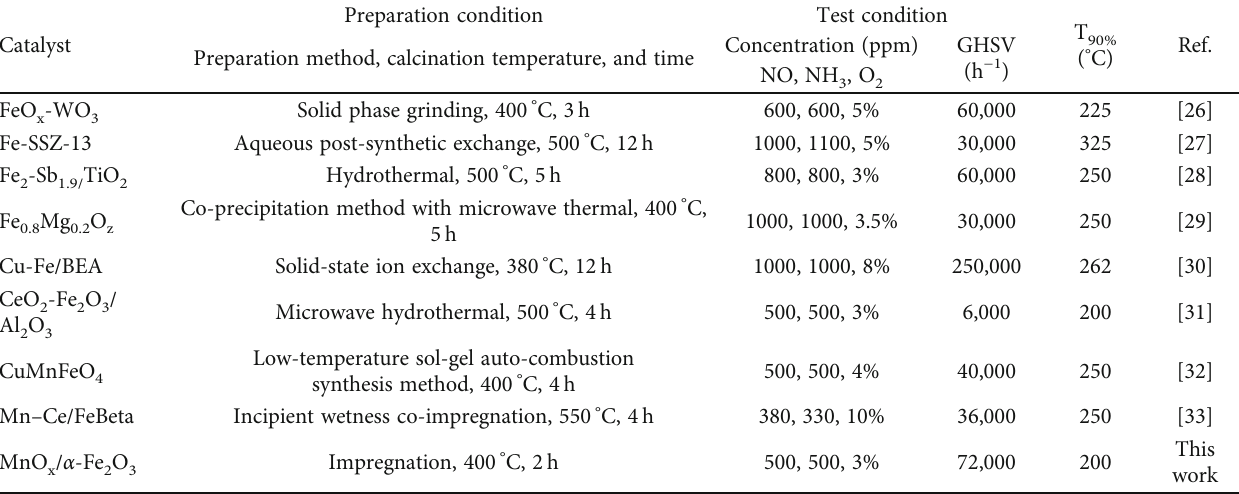
Table 1: Denitration e ffi ciency of catalysts reported in the